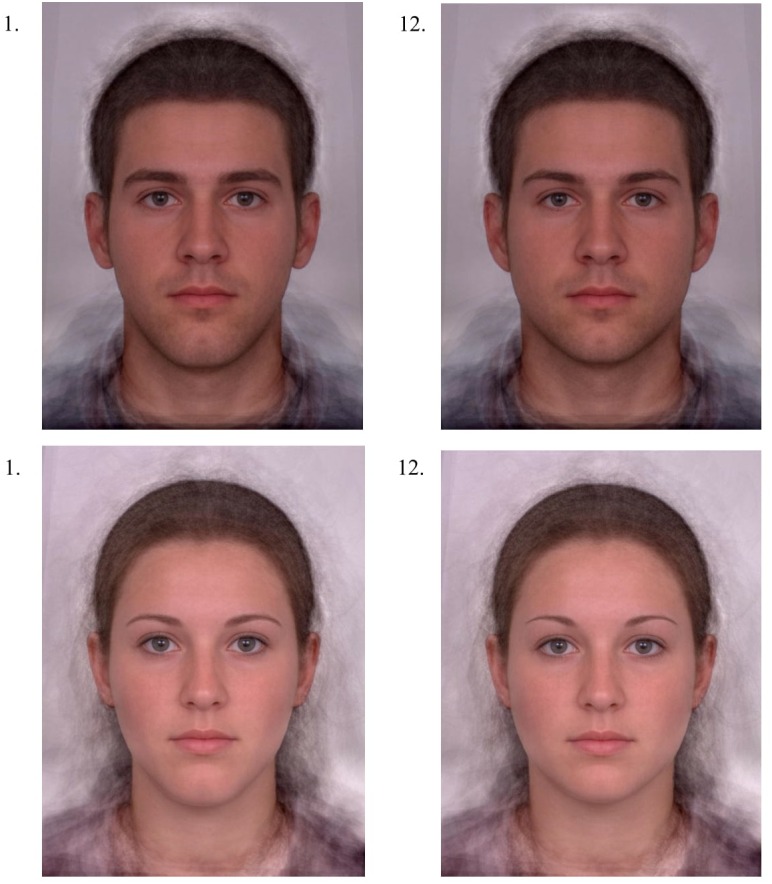
Examples of composite male (top) and female (bottom) images to which one or more of the five digital transformations were applied according to an orthogonal array (see Table 1). Numerical labels correspond to the “Imagine Variation” number listed in Table 1. Base composite images were borrowed from previous work (e.g., Perrett et al., 1998; Penton-Voak et al., 1999; Jones et al., 2005; Welling et al., 2007).